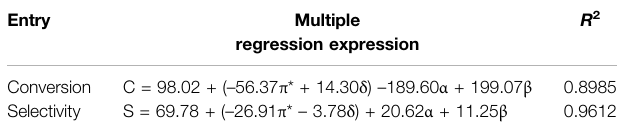
TABLE 5 | The correlation between LSER equations and conversion and